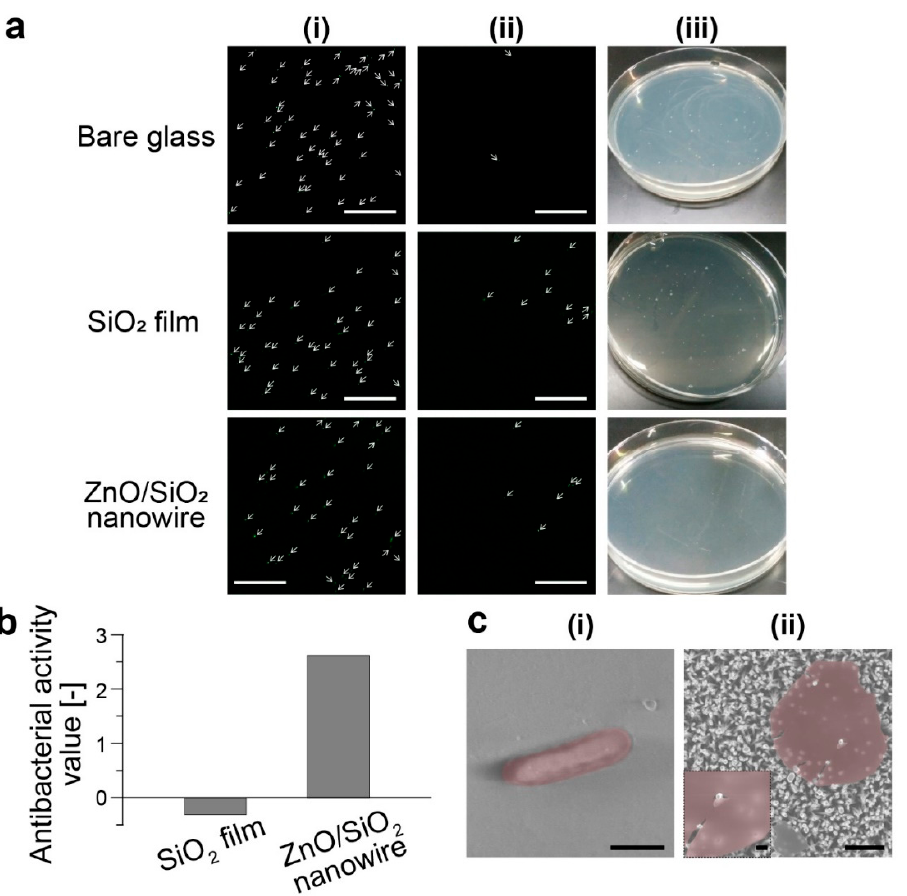
Figure 3. ( a ) Counting viable bacteria cultured on each substrate. (i,ii) Fluorescence images of bacteria on each substrate (i) before and (ii) after washing out (scale bars, 100 µm). (iii) Photographs of an agar medium with colonies. Bacteria collected from each substrate were cultured on an agar medium to count colonies. ( b ) Antibacterial activity value for each substrate. Antibacterial activity value was normalized by that of the bare glass substrate. ( c ) SEM images of a bacterium cultured on (i) bare glass substrate (scale bar, 1 µm) and (ii) ZnO/SiO 2 nanowire substrate (scale bars, 1 µm and 200 nm (insertion)).